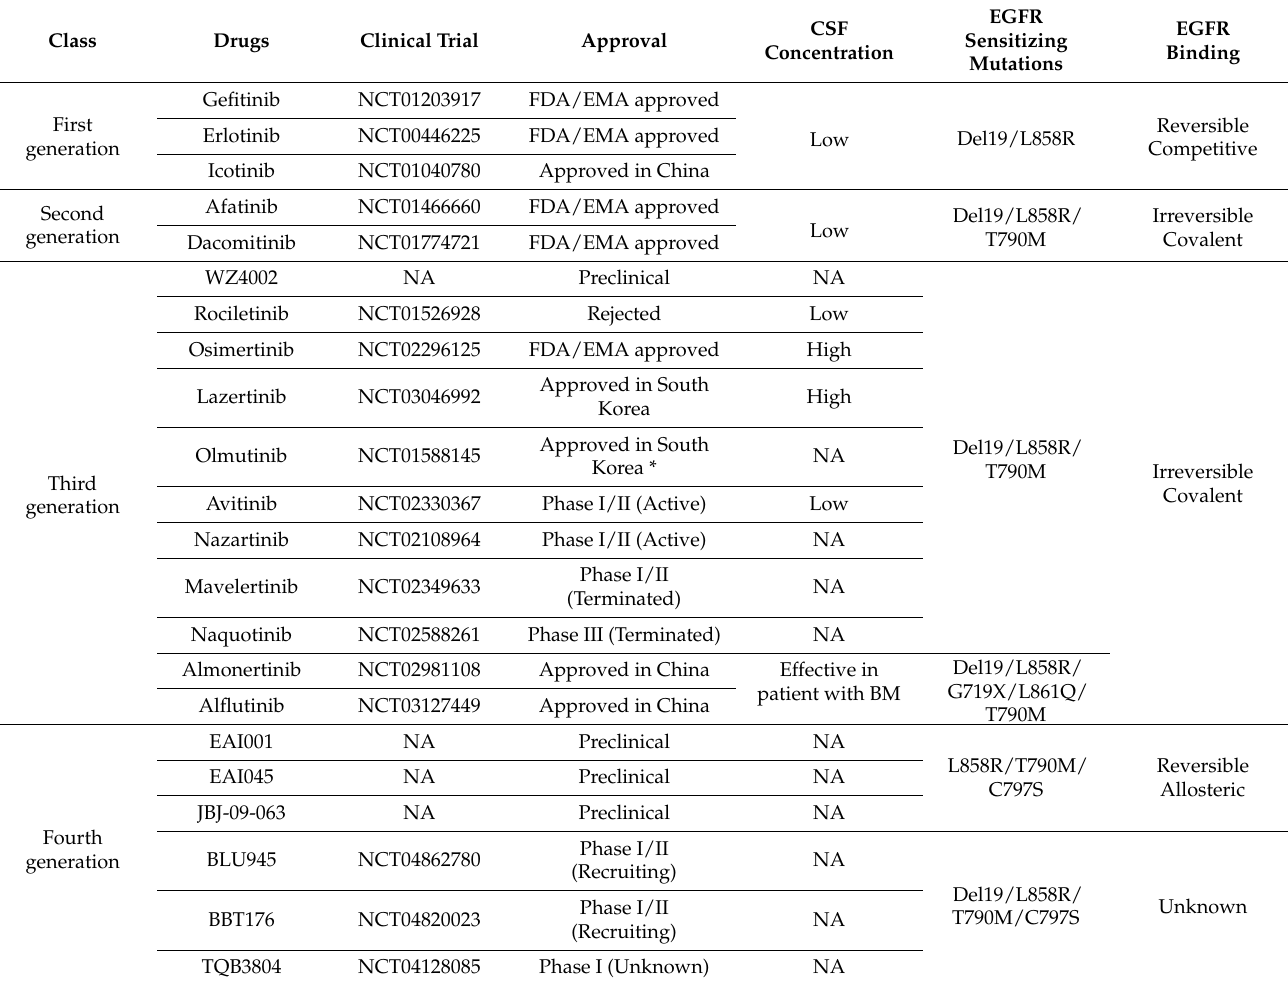
Table 1. Different Generations of EGFR-TKIs for